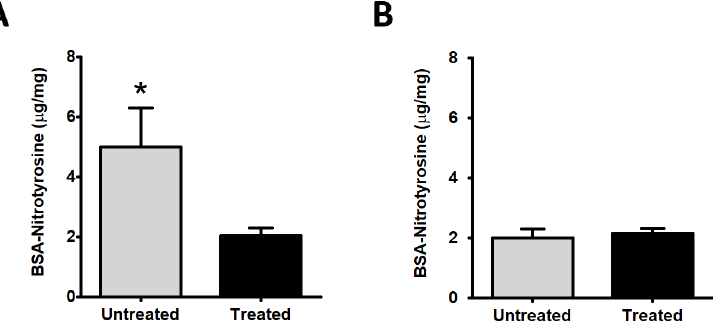
Fig 3. Reduced protein nitrosylation in the RPE following zeaxanthin treatment. In response to zeaxanthin treatment for 4 months, Sod2 flox/flox VMD2-cremice (n = 5) at 6 months of age showed a reduced level of nitrotyrosine in the RPE/choroid (A) but not in the retina where levels were already low (B) compared to eyes from untreated control Sod2 flox/flox VMD2-cremice (n = 5) by ELISA ( (cid:3) P < 0.5).